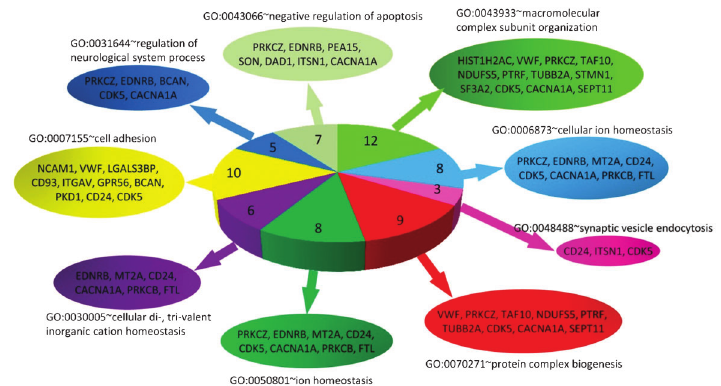
Figure 3. GO (gene ontology) enrichment anal- ysis of 73 differentially expressed